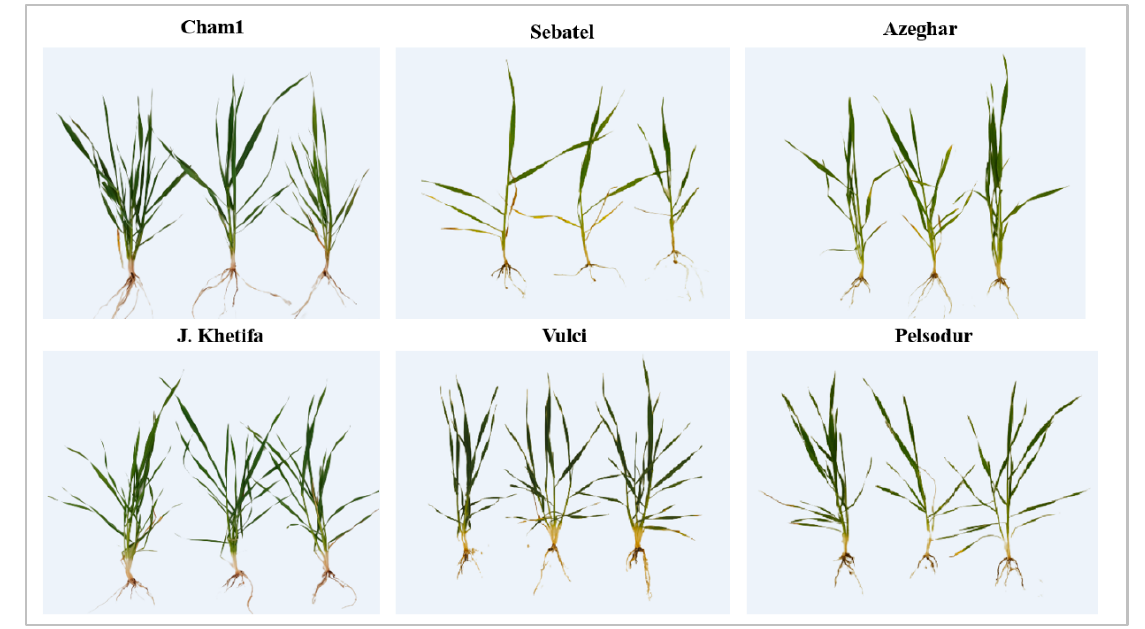
Figure 5. Pictures of six durum wheat genotypes grown in field. Table 4. Root characteristics of plants collected from field at a depth of the first 5 cm below ground. Azeghar Cham1